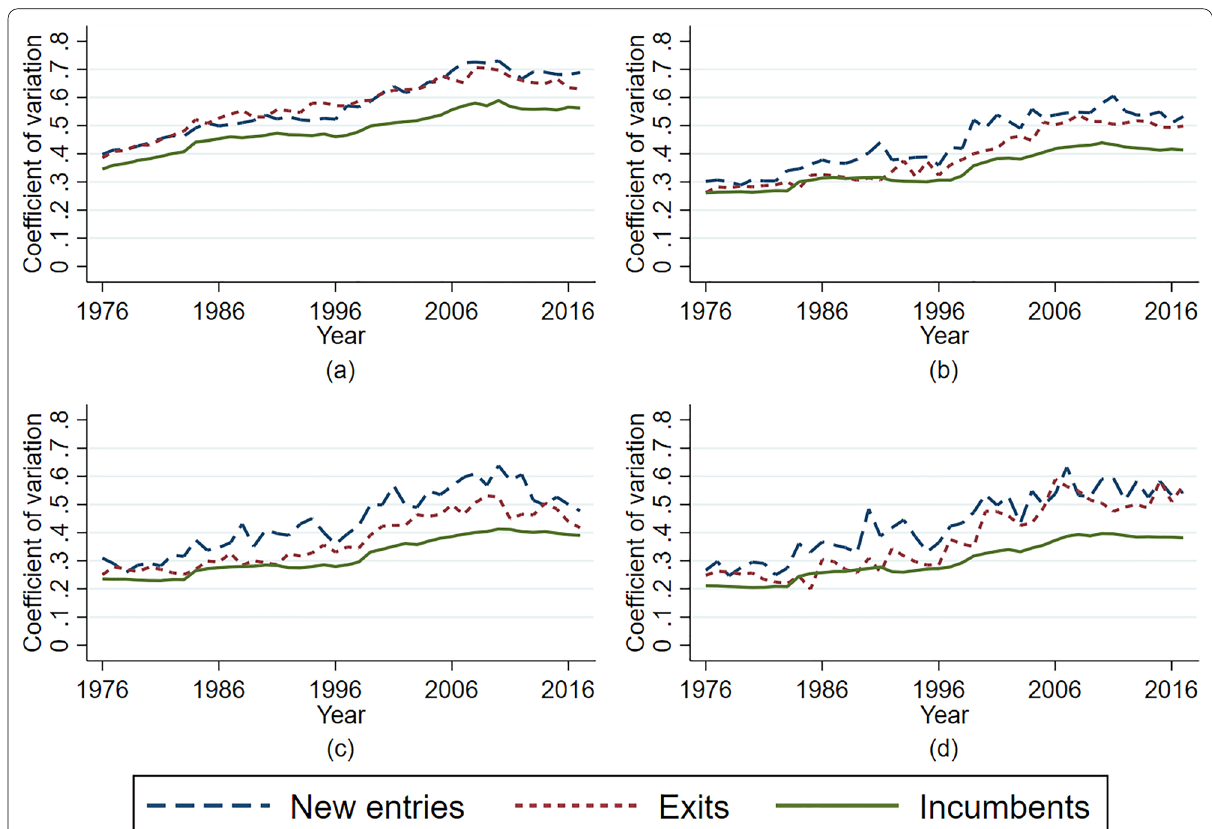
Fig. 4 Coefficient of variation of the average wage distribution in various establishment size classes. a 1–9 employees, b 10–19 employees, c 20–49 employees, d 50 +